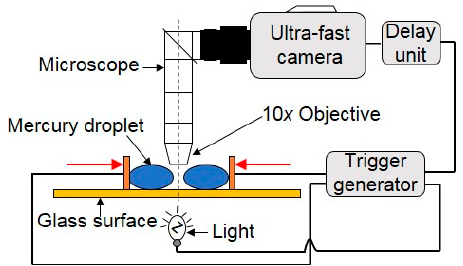
Figure 8. The ultra-fast analog camera set-up used to obtain a magnified view of the contact region of two mercury droplets.